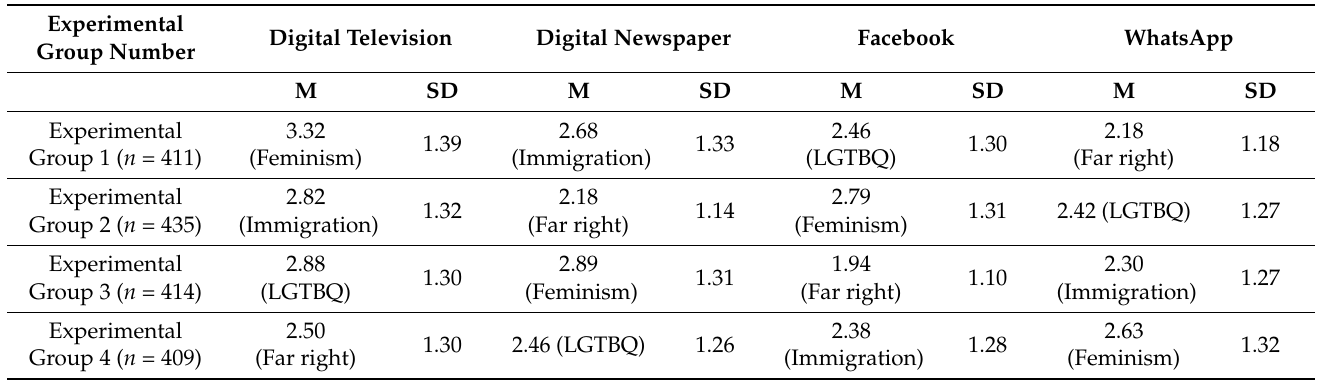
Table 7. Likelihood to share the news items via the social media, by format.